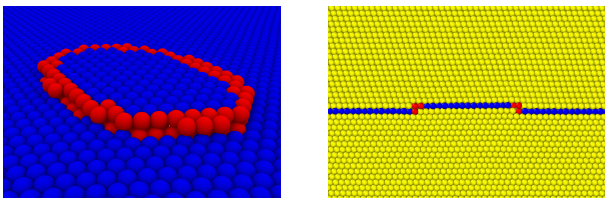
Figure 6. Left: partial dislocation loop (red) on twin plane (blue). Right: cross section of loop and twin plane (blue) in fcc lattice (yellow). As shown, interface partial glide results in normal boundary motion. See text for discussion.